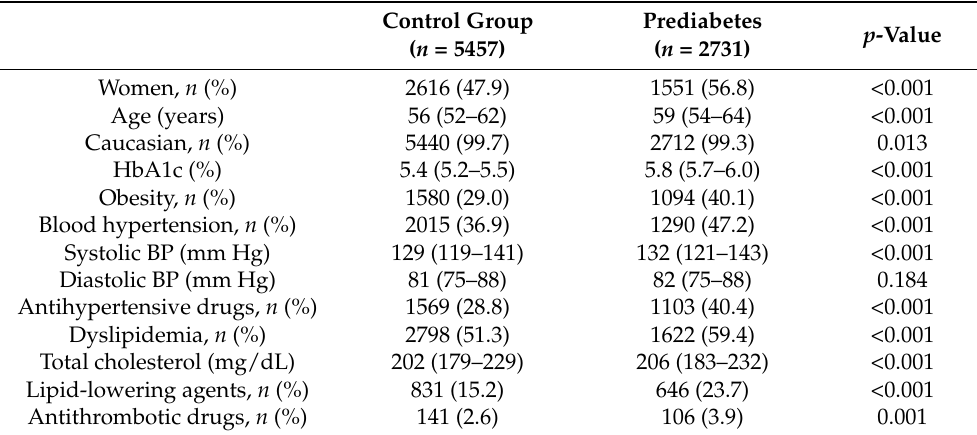
Table 1. Main clinical and metabolic data in the study population according to the presence of prediabetes.